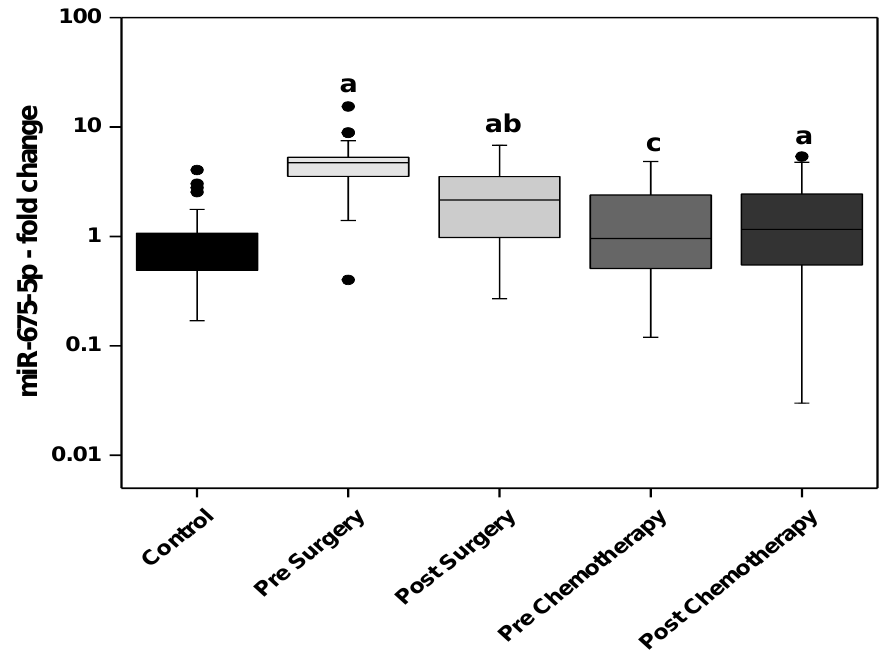
Figure 3. The circulating levels of miR-675-5p in the control subjects and the BC studied groups; surgery only and adjuvant chemotherapy. Extreme value: a — Significant between control and each group by using Post Hoc Test (Dunn’s), Kruskal Wallis test , b — Significant between pre and post in same group by using Wilcoxon signed ranks test, c — Significant between post-surgery and prechemotherapy by using Mann Whitney test.